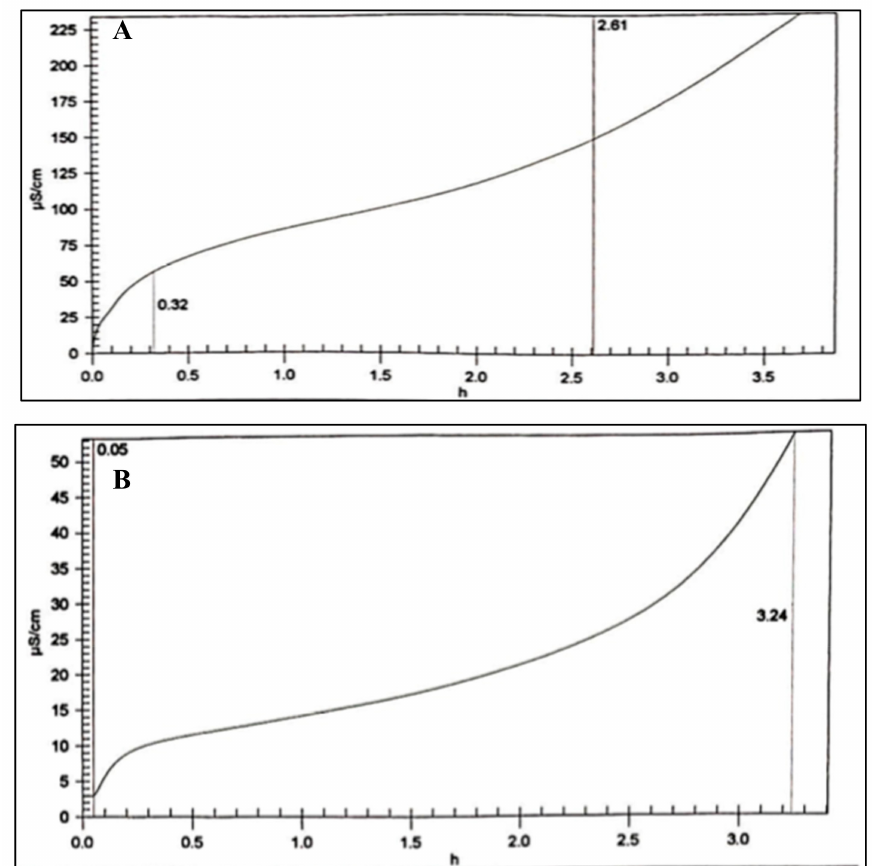
Figure 16. Induction period of ( A ) biodiesel and ( B ) biodiesel combined with pyrogallol derivative using Rancimat